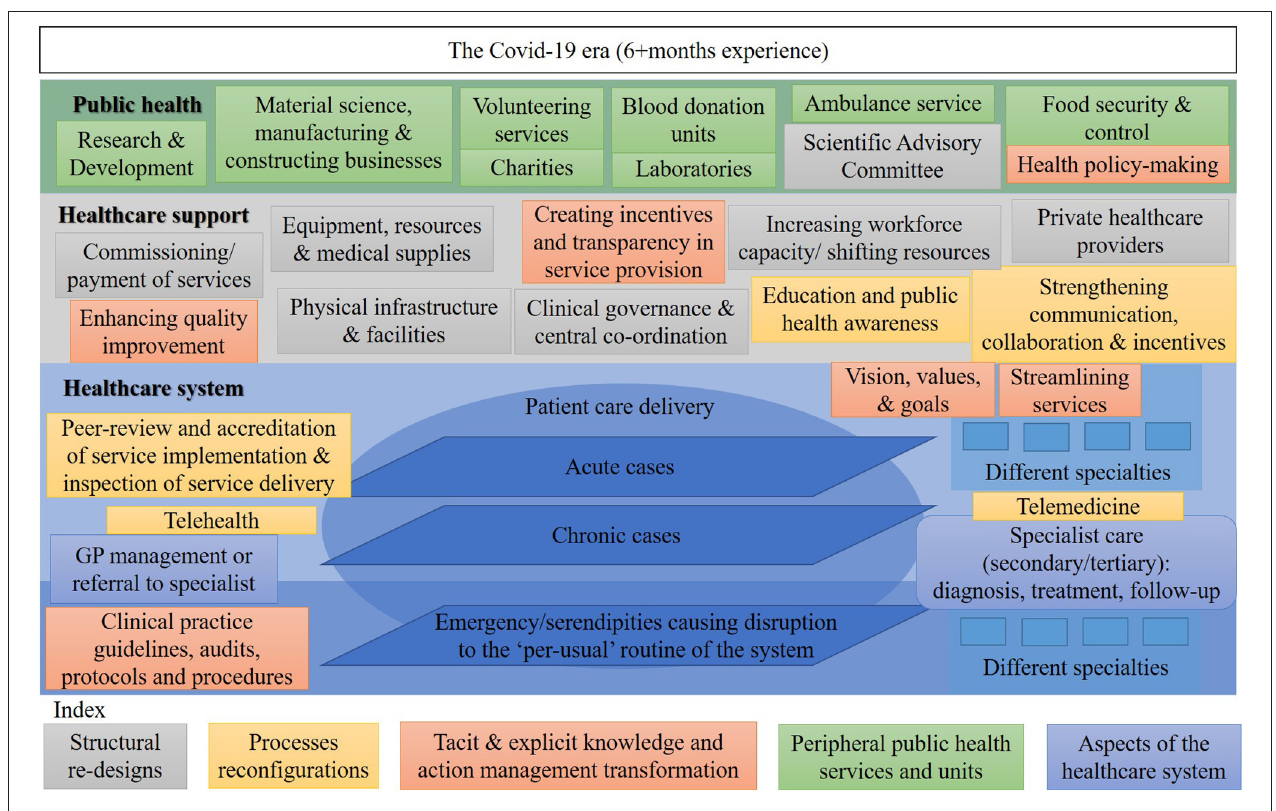
FIGURE 3 | The shifted healthcare service model six + months into the COVID-19 pandemic in Cyprus.